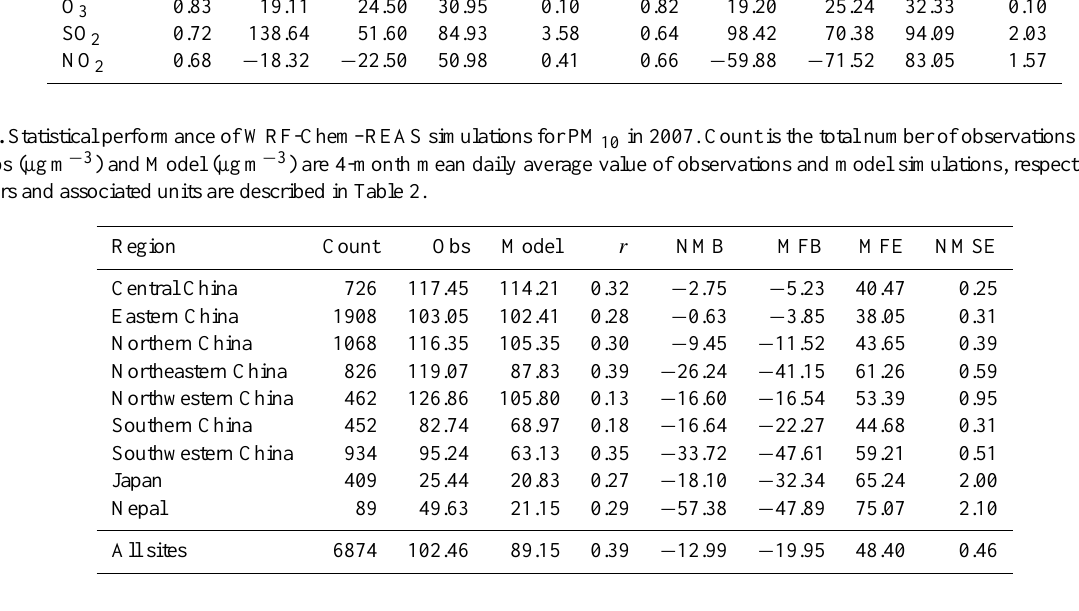
same pollutants at all available stations. The comparisons between daily modeled and observed concentrations of each pollutant are given in Figs. 5, 6, 8, and 11 for individual sites. Detailed analyses of model biases and errors for each of the species are provided in the following